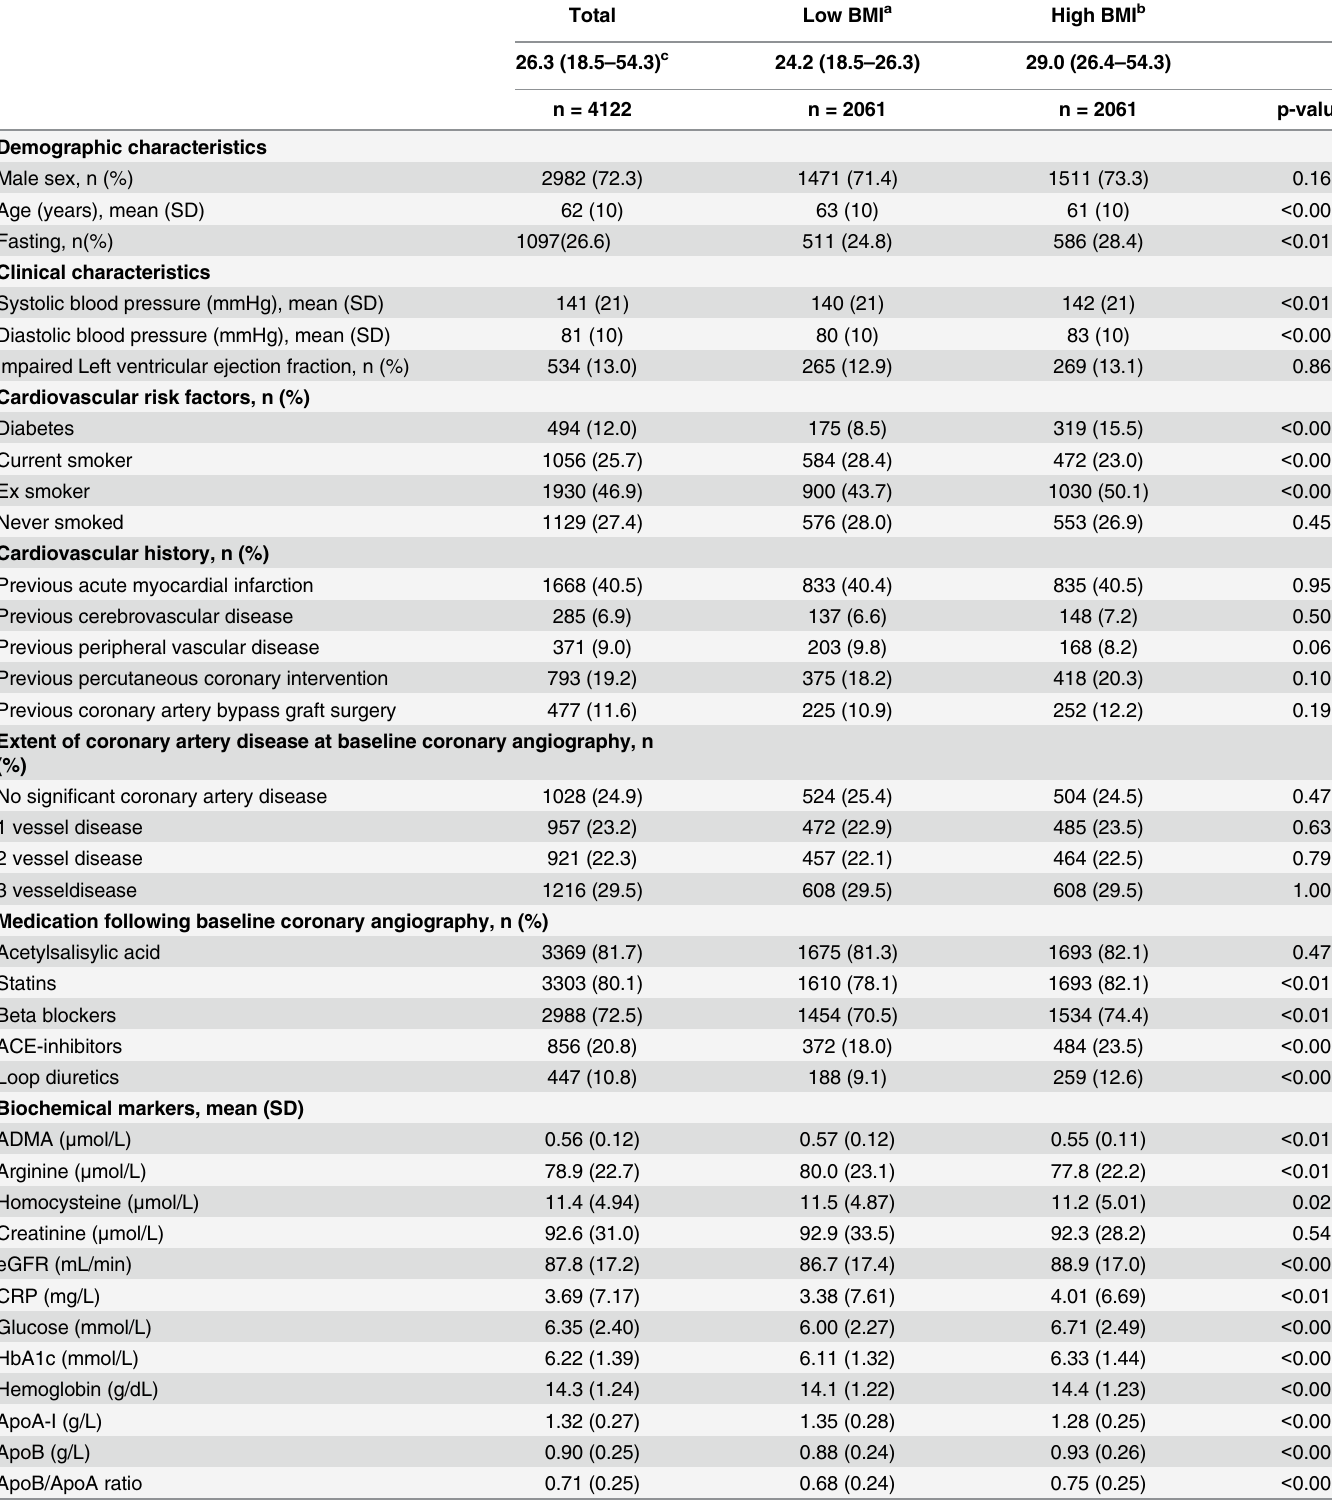
Table 1. Baseline characteristics in the total population and according to patients with low and high